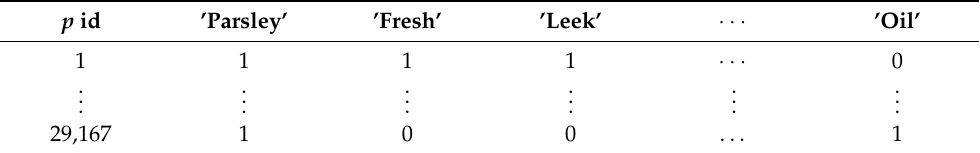
Table 7. Example of a product matrix .